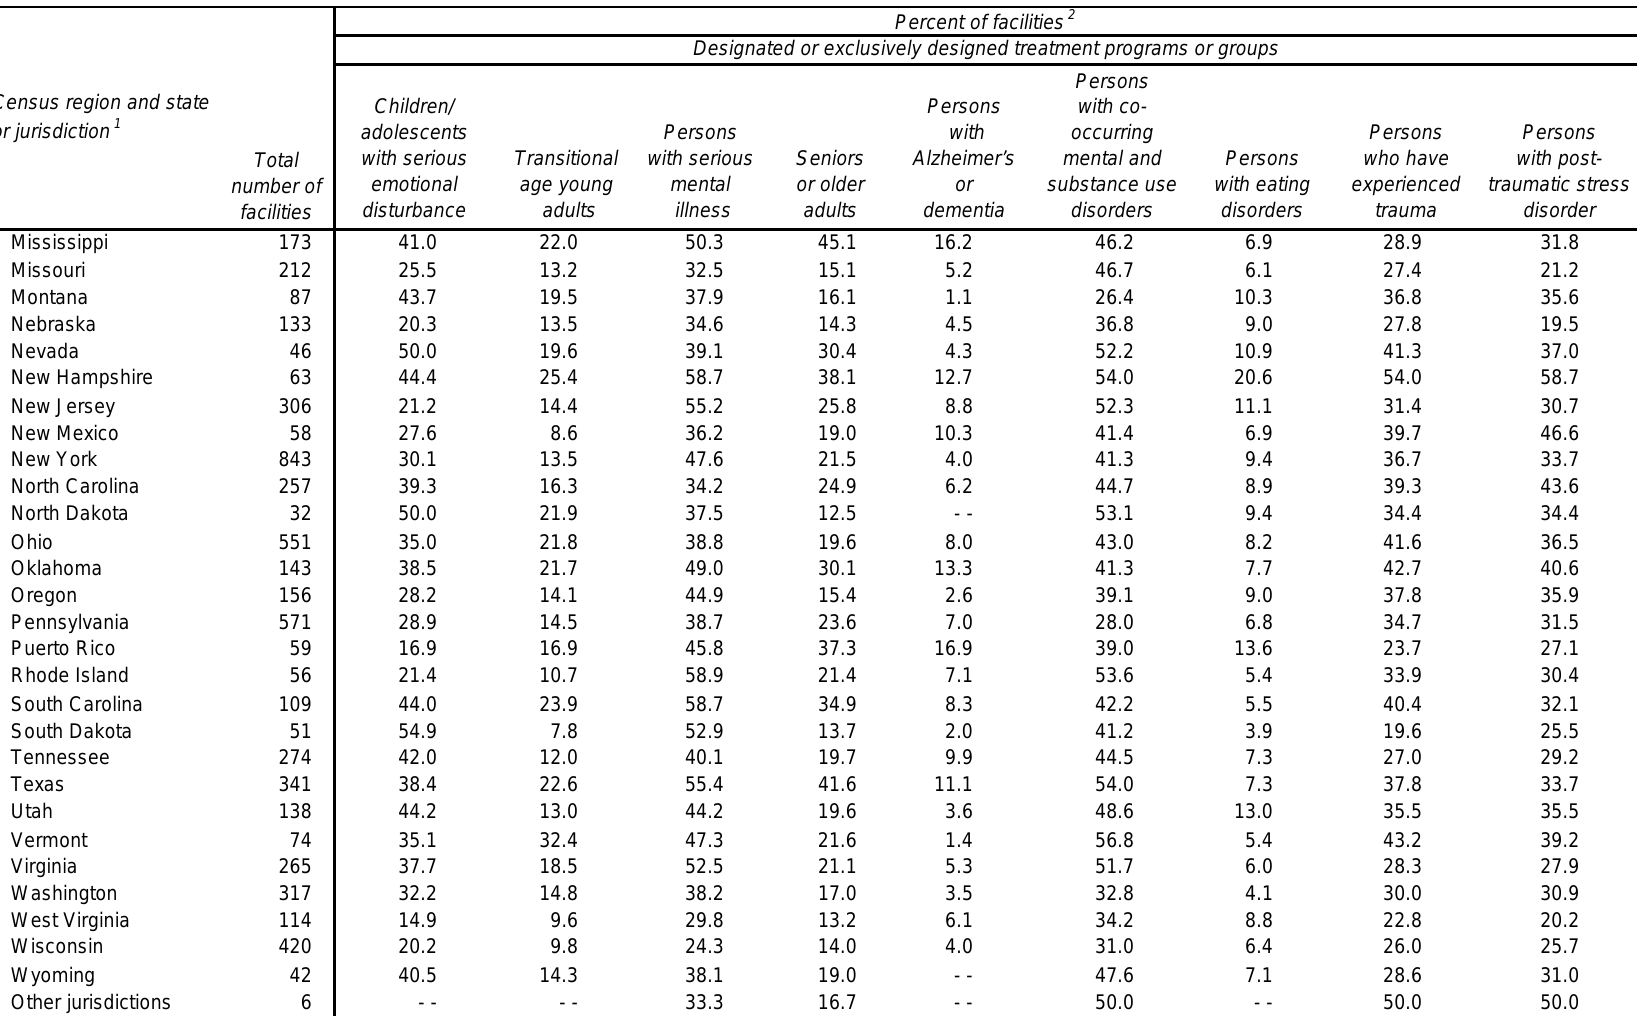
Table 3.10b. Mental health treatment facilities offering treatment programs or groups designated or designed exclusively for specific client categories,